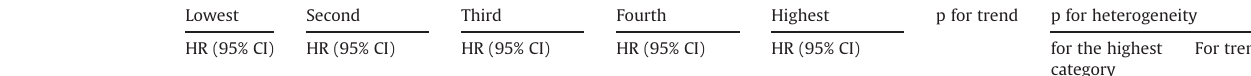
for the highest